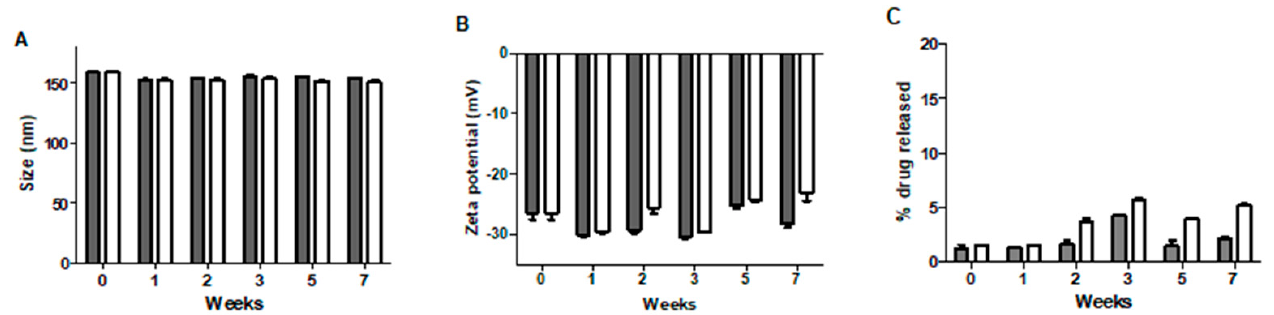
Figure 6. Change in size ( A ), zeta potential ( B ), and drug release ( C ) of Dox-loaded ABN-SPDP at different time points at two different temperature conditions, 4 °C (gray) and RT (white). Till the end of 2 months, the ABN-SPDP were stable. The data are presented as mean ± standard deviation (SD).